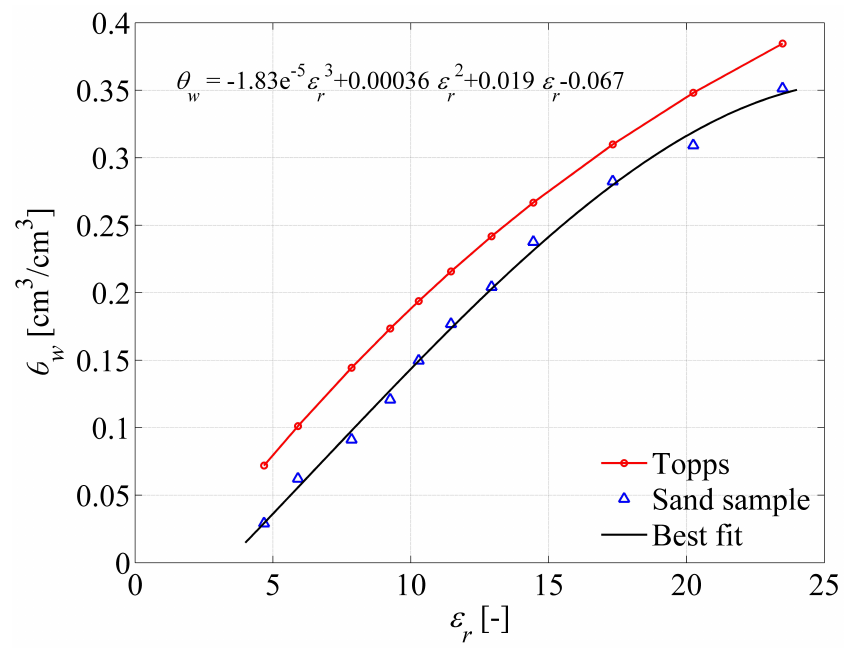
Figure 2. Plot showing the relationship between permittivity ( ε r ) and soil moisture content ( θ w ). The red line in the plot represents the Topps equation [26] which the sensors use to calculate the soil moisture content and the black line is the best-fit of a cubic equation through the measurement